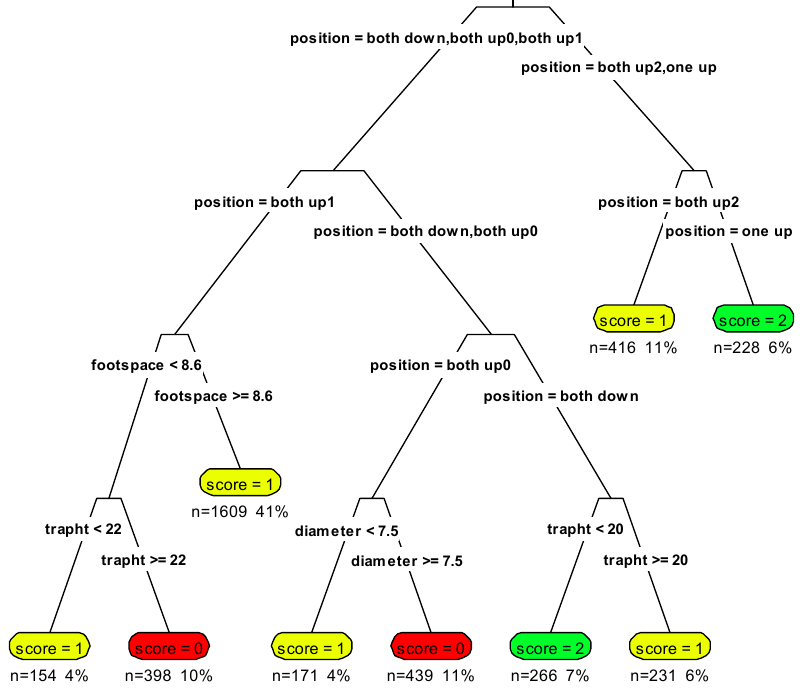
Figure 4. Classification and regression tree (CART) plot illustrating the influence of foot positioning (position), trap height (trapht), foothold spacing (footspace), and platform diameter (diameter) on ventral scores. Ventral scores are highlighted within each terminal node (0 = red, 1 = yellow, 2 = green), and the number of observations (n), and percent occurrence (%) for each node are listed directly below. The highest ventral scores ( i.e. , 2; green) were associated with traps that were spaced <20 cm above feeding platforms and when foot positioning was both down or one up. Note : See methods for a detailed description of foot positioning.